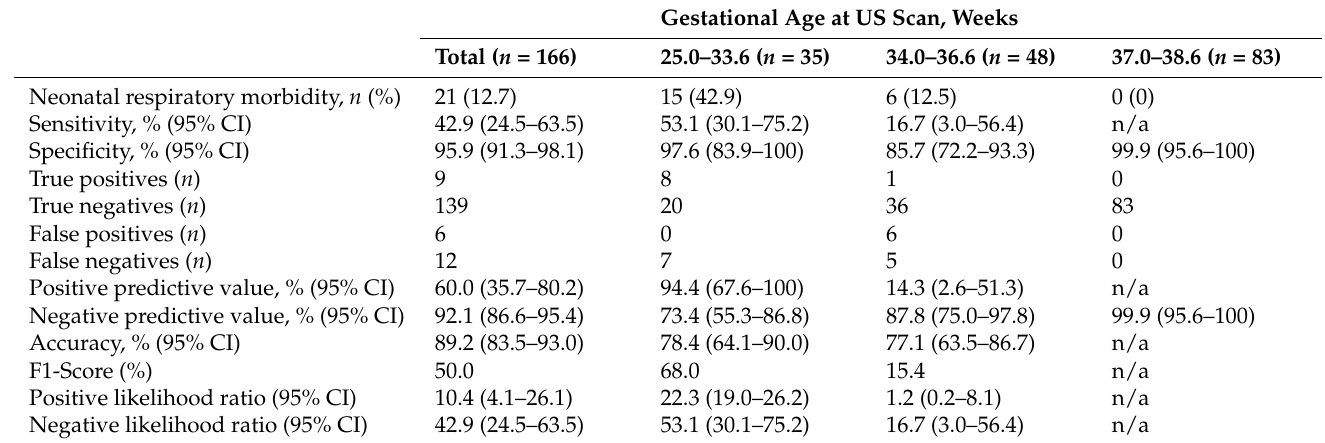
Table 3. Performance of quantusFLM in predicting neonatal respiratory morbidity in twin